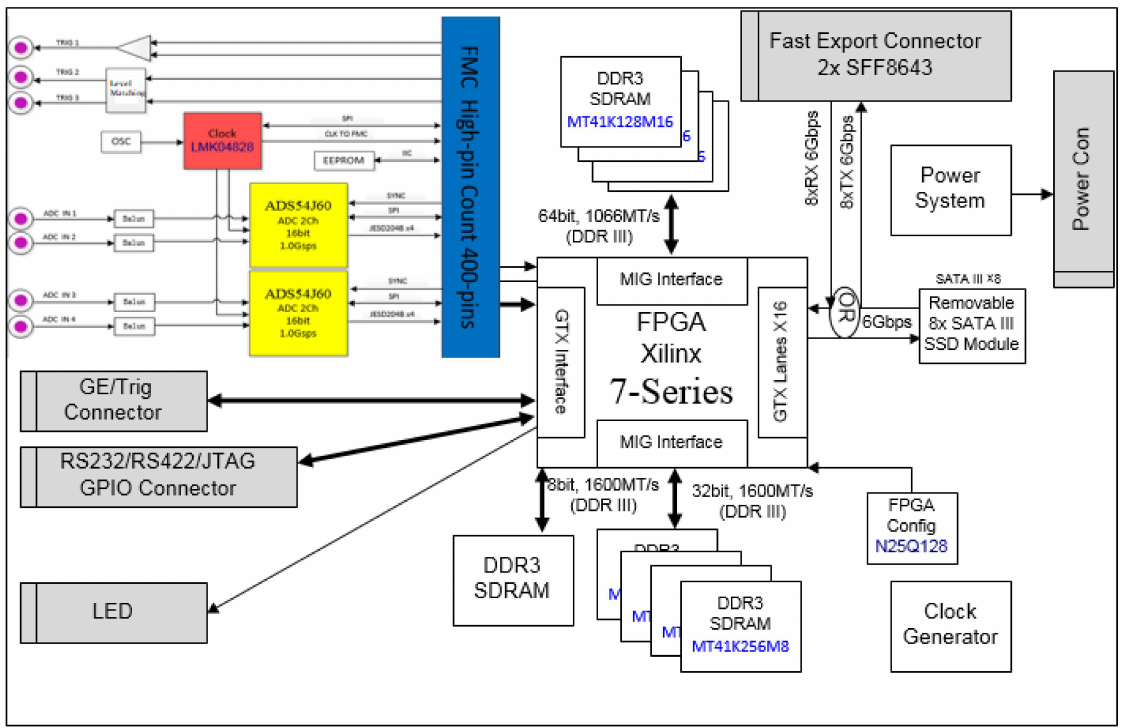
Figure 13. Architecture of high-speed AD sampling system for GQ-Cor